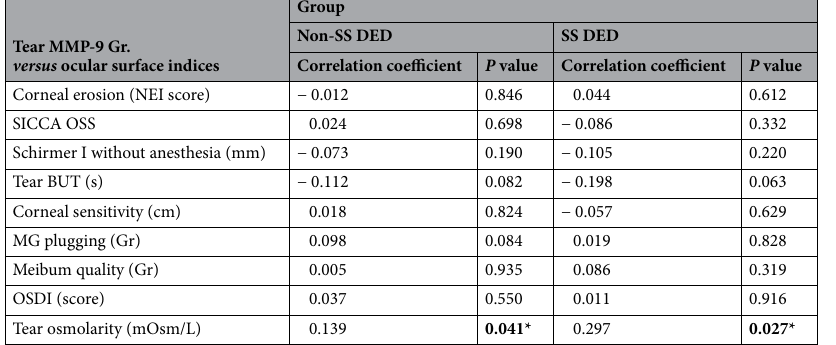
Table 6. Correlations of ocular surface indices with the grades of tear matrix metalloproteinase 9 (MMP-9) expression according to the 5-scale grading system in subjects with dry eye disease (DED) with and without primary Sjogren’s syndrome (pSS). * P < 0.05. Gr, grade. OSDI, ocular surface disease index. OSS, ocular staining score. BUT, break-up time. MG, meibomian gland. Significant are in value [bold].